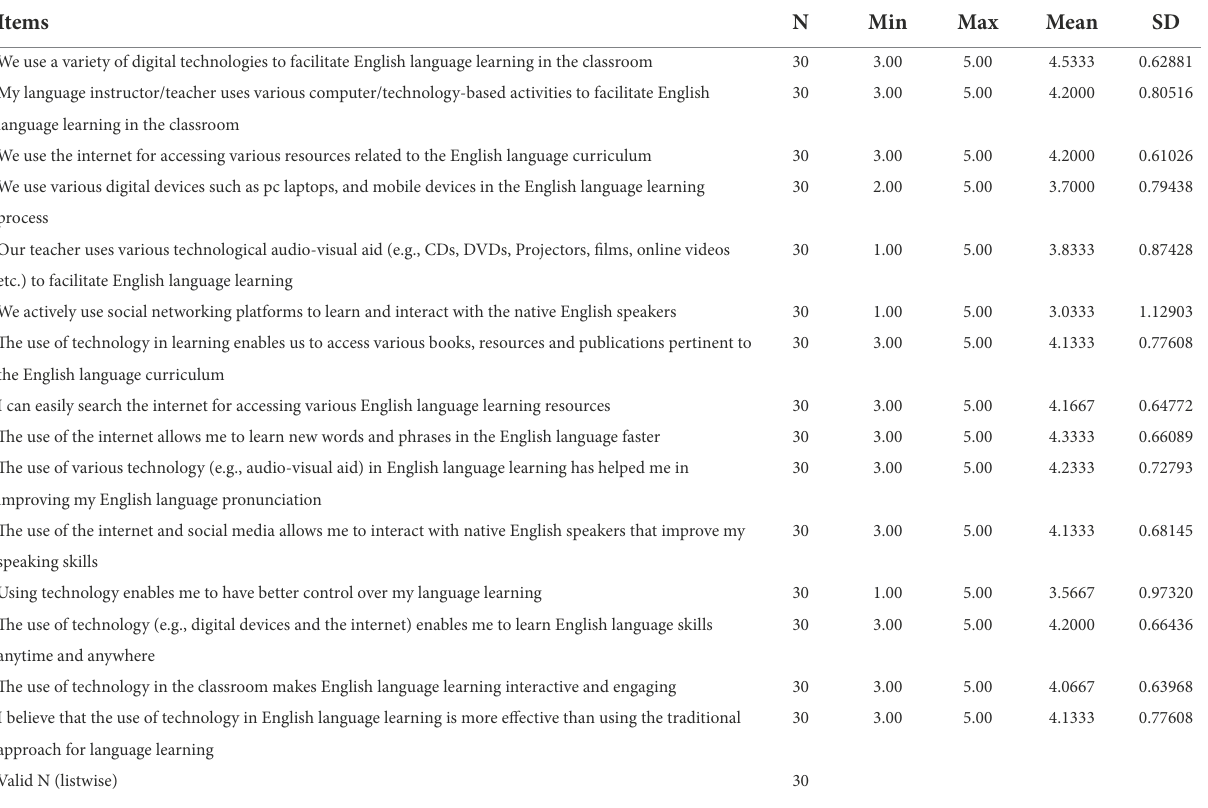
TABLE 2 Survey results of Russian linguistic